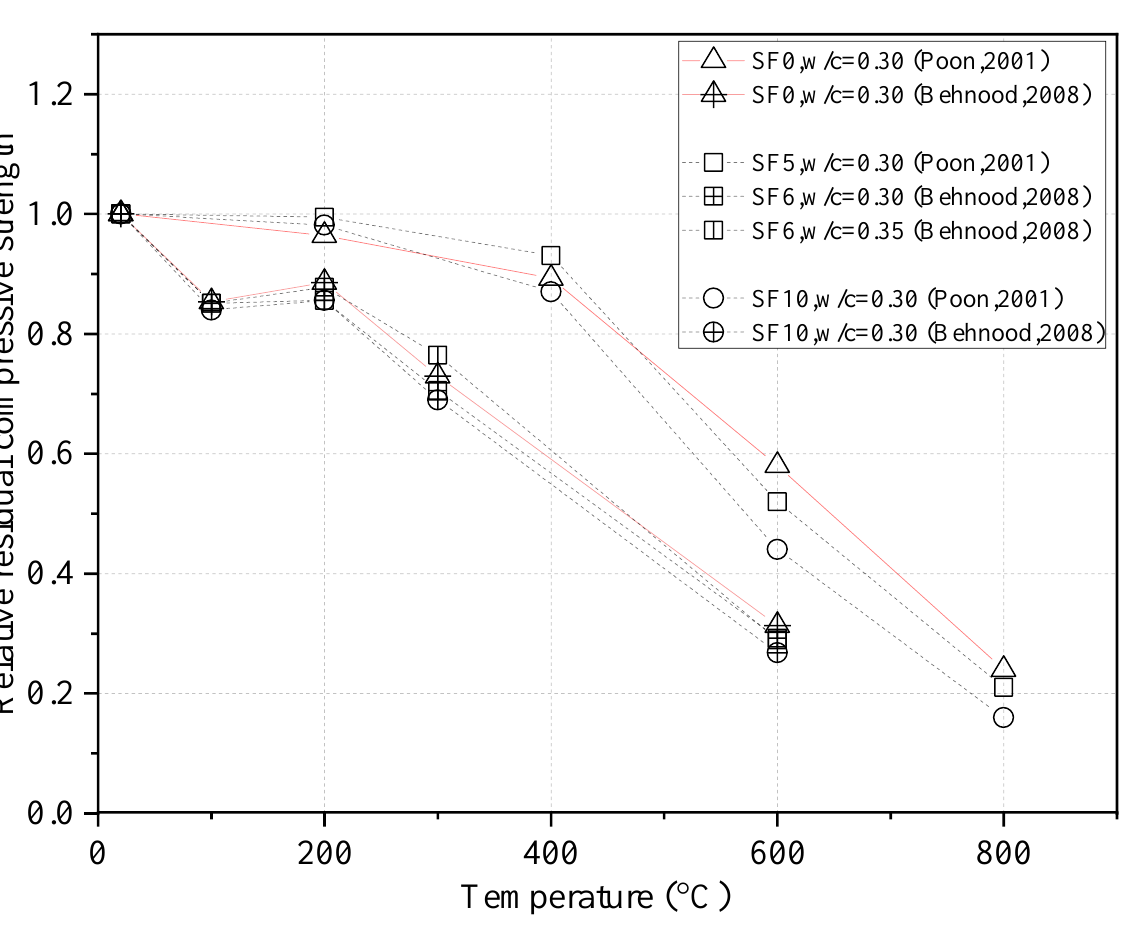
Figure 3. The relative residual compressive strength of concrete containing silica fume (SF) at different water-to-cementitious materials ratios (w/c) [15,35].